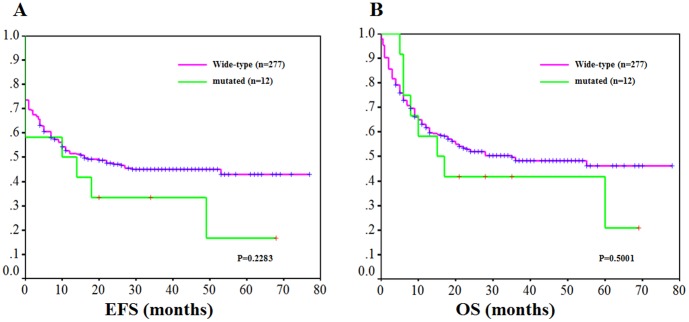
Kaplan-Meier survival curves according to EZH2 mutation status.(A) EFS in de novo AML patients according to EZH2 mutations. The green line represents patients with mutated EZH2 (n = 12); and magenta line, patients with unmutated EZH2 (n = 277; P = 0.2283); (B) OS in de novo AML patients according to EZH2 mutations. The green line represents patients with mutated EZH2 (n = 12); and the magenta line represents patients with unmutated EZH2 (n = 277; P = 0.5001).